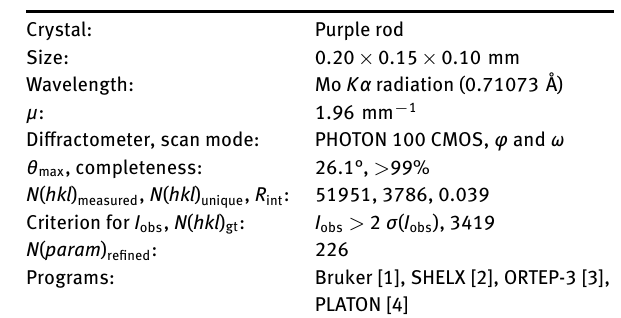
Table 1: Data collection and handling.